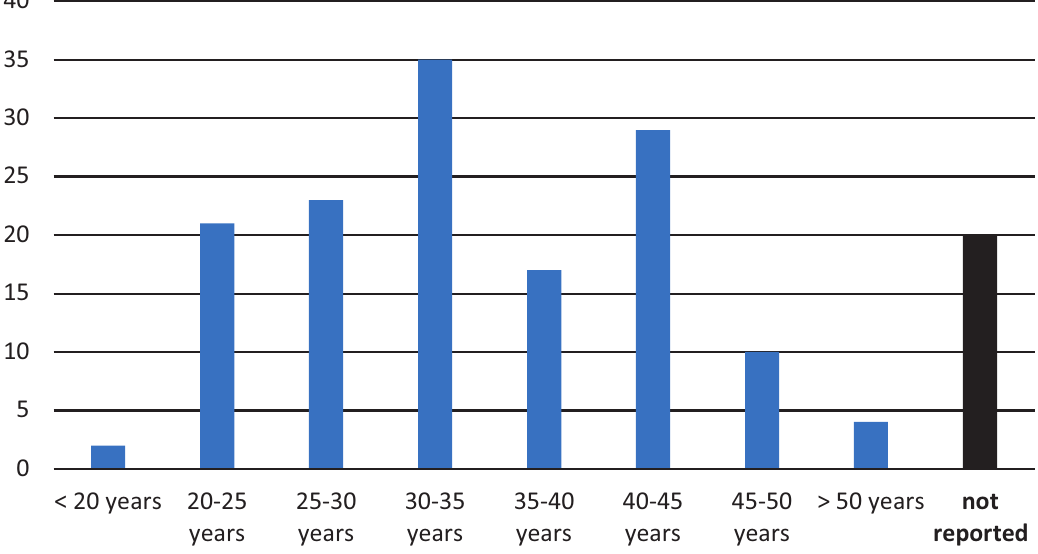
Figure 4. Frequencies ( n ) of age groups as used in the analyzed automated driving